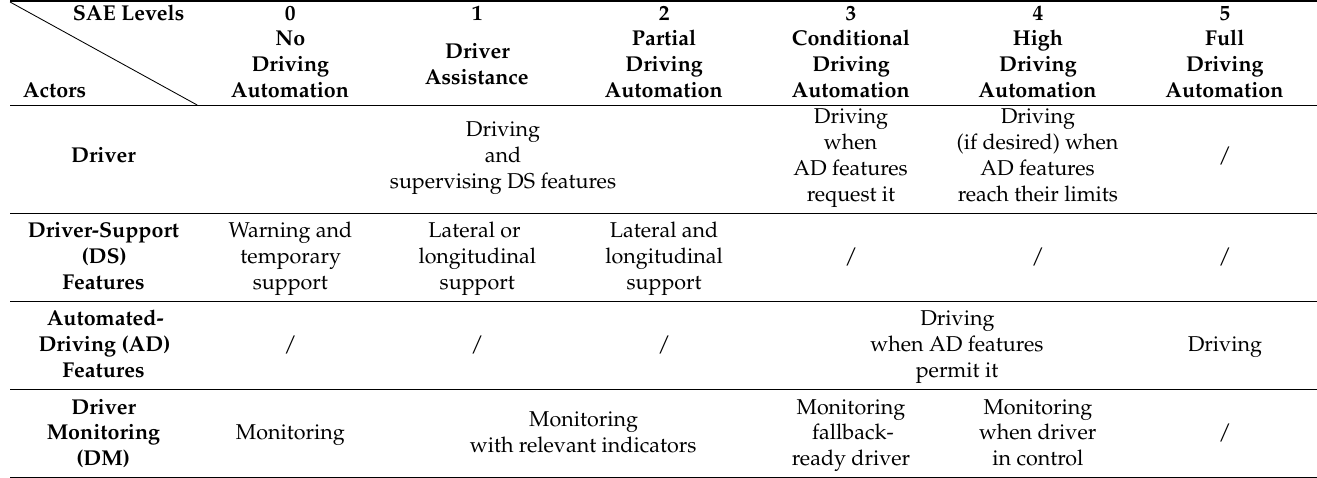
Table 1. This table shows the role played by each of the four key actors, that is, driver, driver-support (DS) features, automated-driving (AD) features, and driver monitoring (DM), at each of the six SAE Levels of driving automation (from 0 to